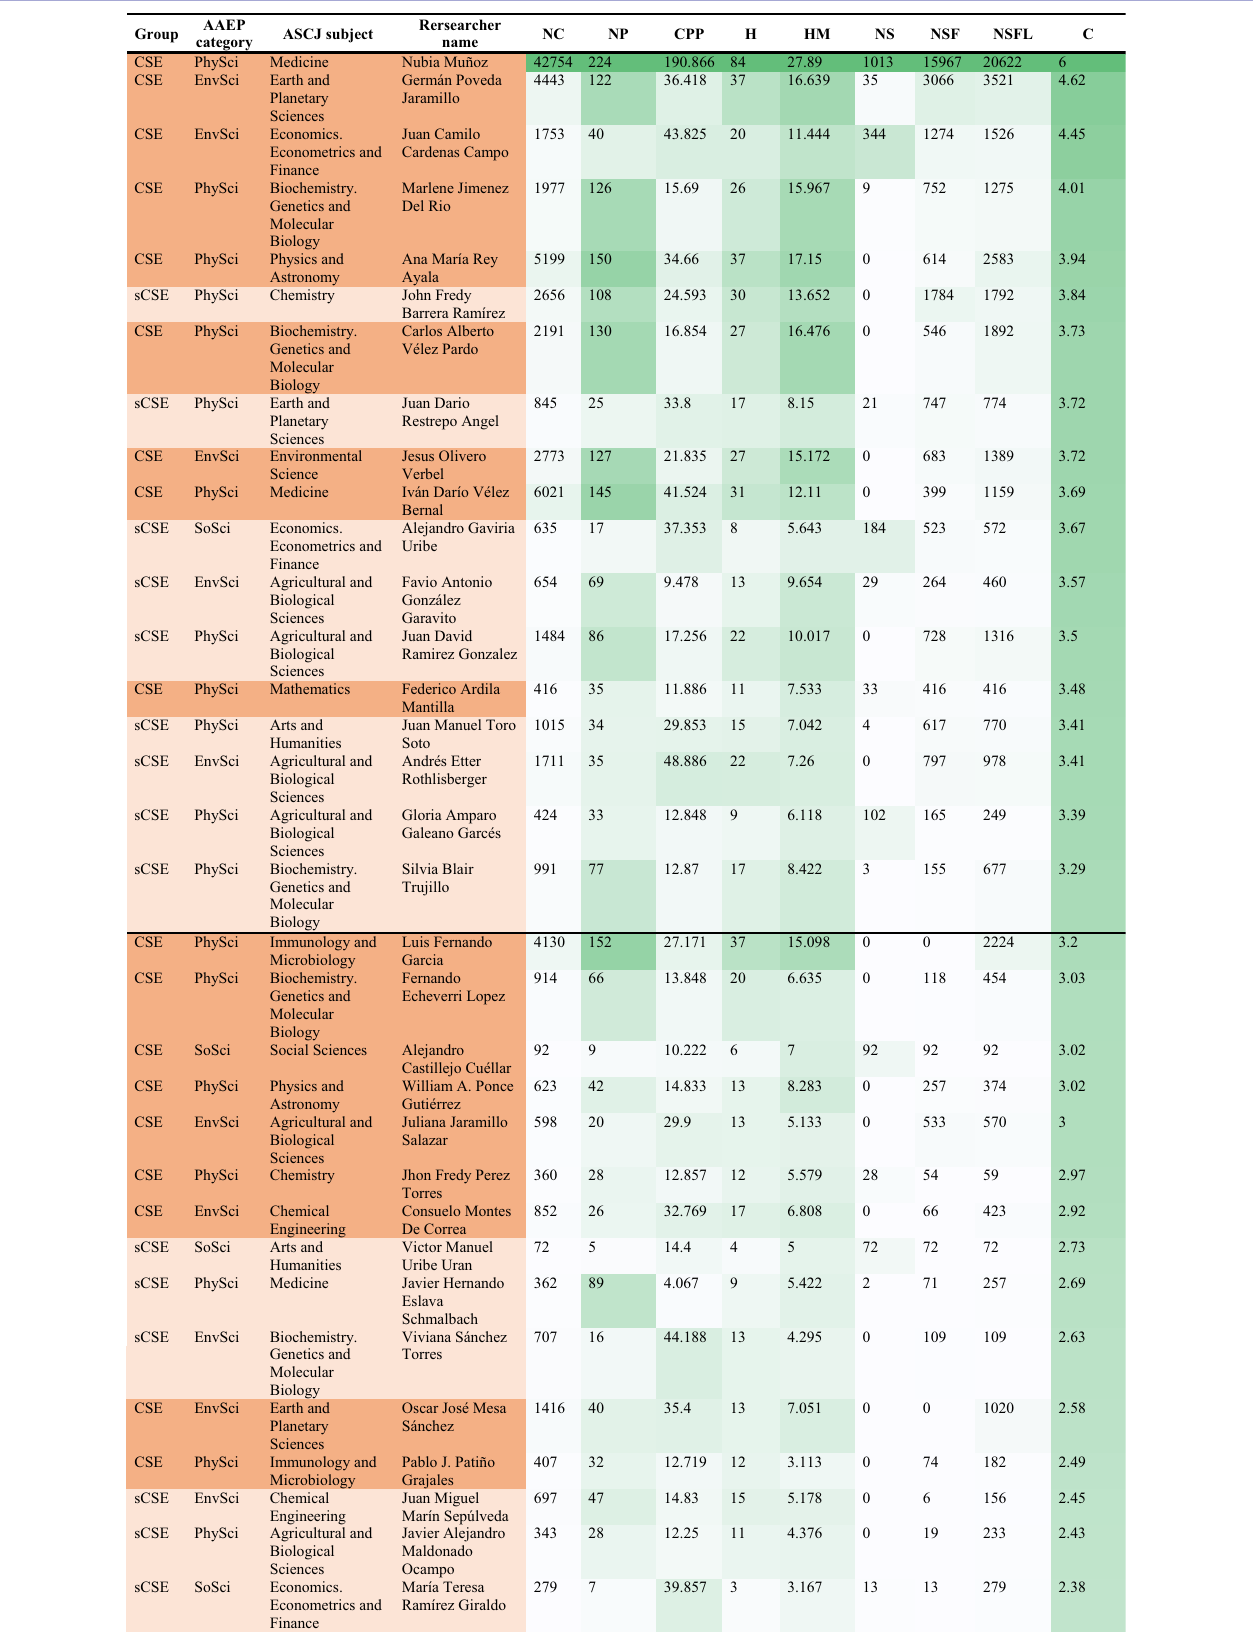
Table 2 Composite citation indicator ( C ) for both the CSE and sCSE. Group AAEP